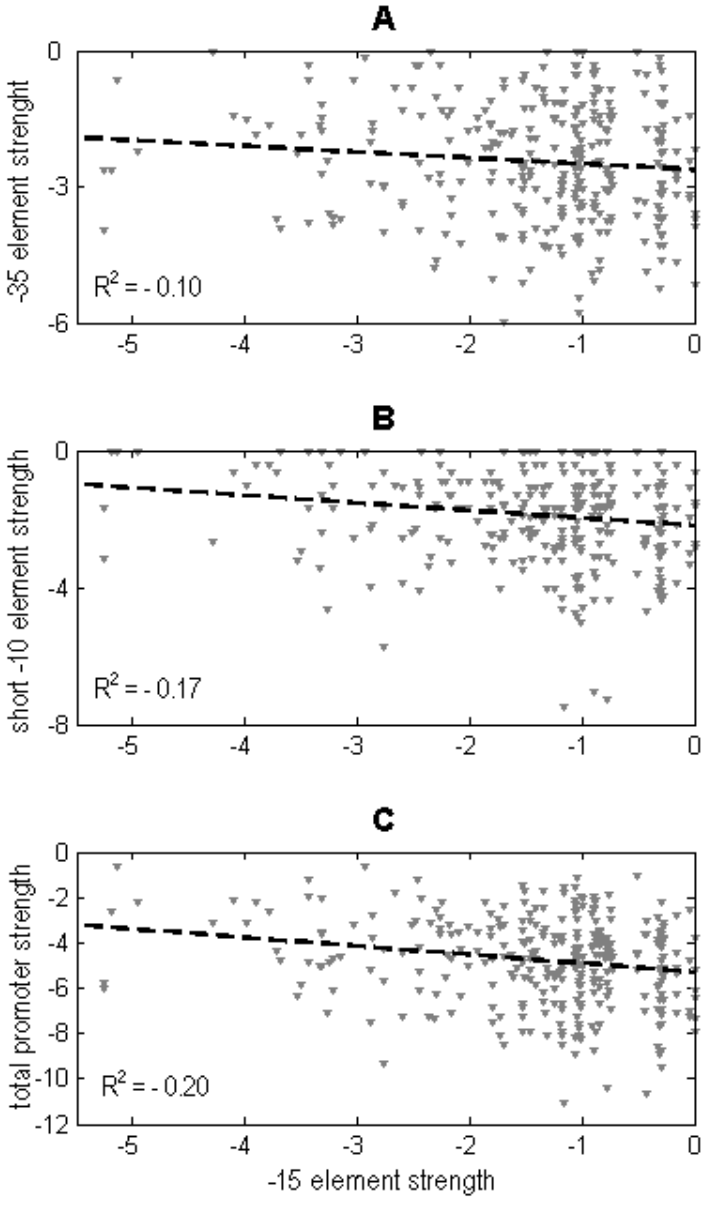
Figure 3 - Correlation of -15 element strength with other promoter strengths. Weight matrices inferred from the alignment are used to calculate strengths of -35 elements, -15 elements, short -10 elements, and the overall promoter strength. Correlations between the following strengths are then shown: A) -15 element and -35 element B) -15 element and short - 10 element C) -15 element and the overall promoter strength. Correlation constants are indicated in the figures. Figure adopted from